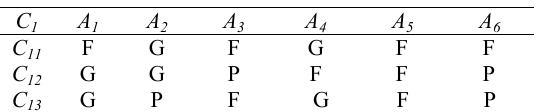
Fig. 1. The hierarchical structure of the recoverable end-of-life products performance evaluation Table 3. Performance assessments of alternatives for Technical ( C 1 ).